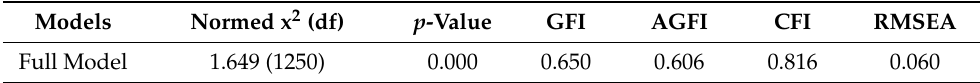
Table 6. Research Model’s AMOS Model